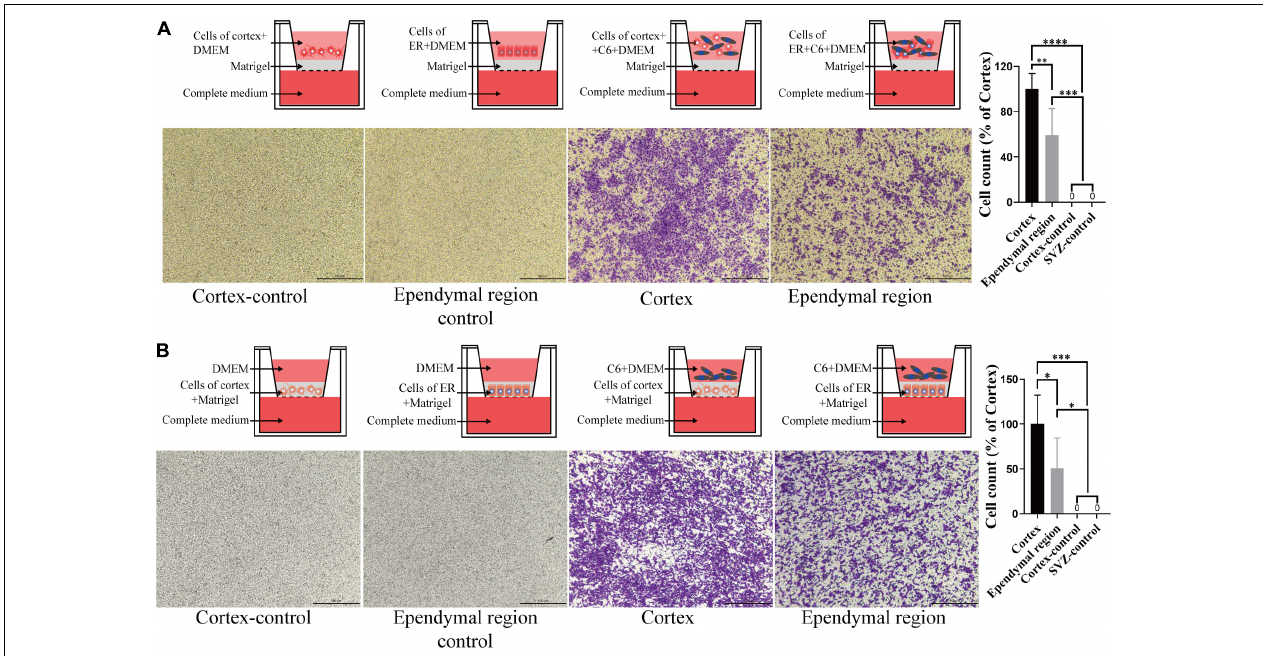
FIGURE 5 | The effect of cell-cell interactions on the invasiveness of GBM cells. (A) Compared with that of the cortex group, C6 invasion ability was decreased after coculture with the ependymal region cell suspension, and neither ependymal region nor cortex cells exhibited invasion. (B) The invasive ability of C6 in the ependymal region groups was weaker than that in the cortex group when the ependymal region or cortex cell suspension was mixed with Matrigel, and neither ependymal region nor cortex cells exhibited invasion. Invasion was allowed to proceed for 4 h. ∗ p < 0.05, ∗∗ p < 0.01, ∗∗∗ p < 0.001, ∗∗∗∗ p < 0.0001; ER, ependymal